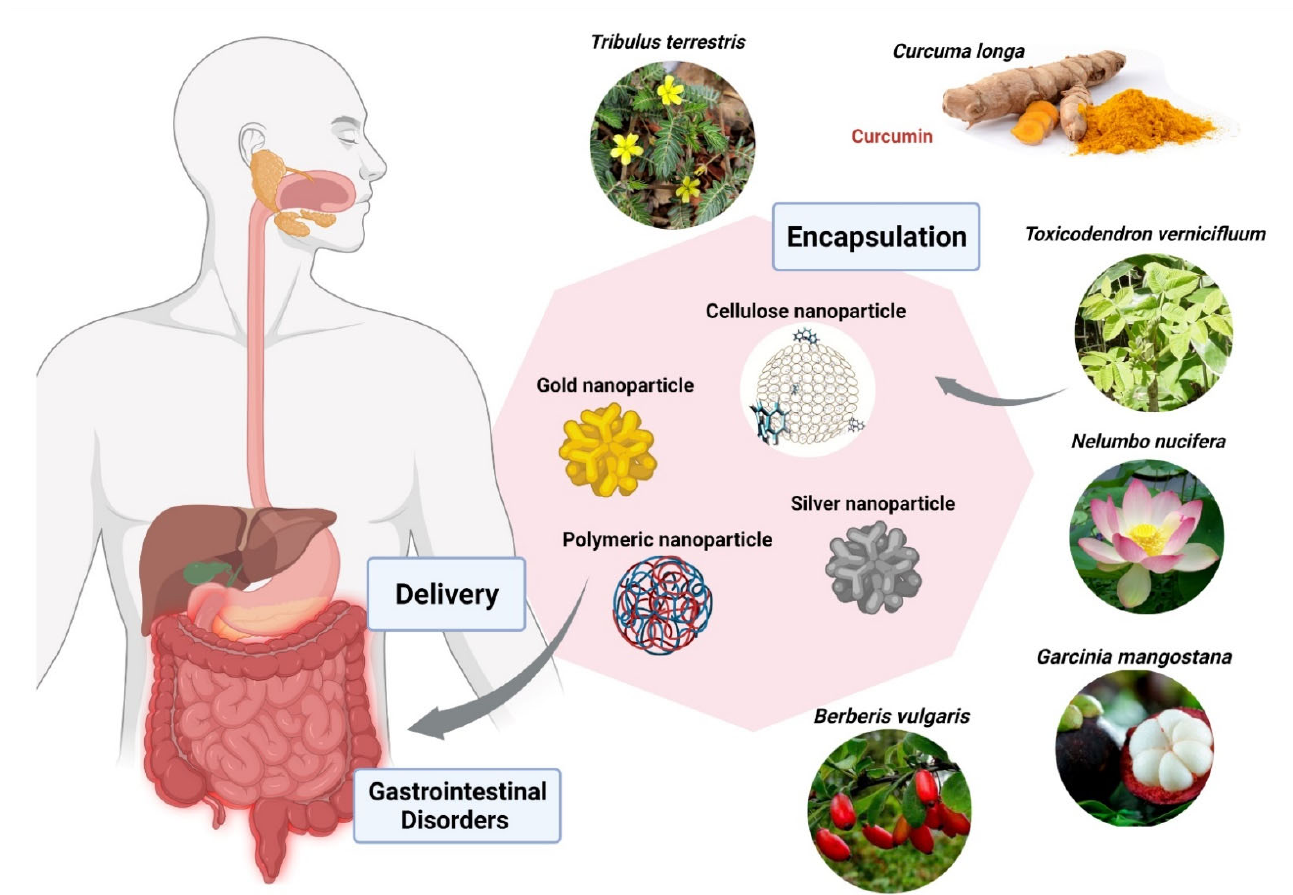
Figure 5. Encapsulation of bioactive compounds from various herbal extracts with silver, gold, cellulose, and polymeric nanoparticles to improve delivery in the gastrointestinal tract, and to prevent or cure various diseases. The figure was made with www.biorender.com (access date: 12 January 2022). Table 3. Nano ‐ phytopharmaceuticals for therapeutic applications in GI disorders.